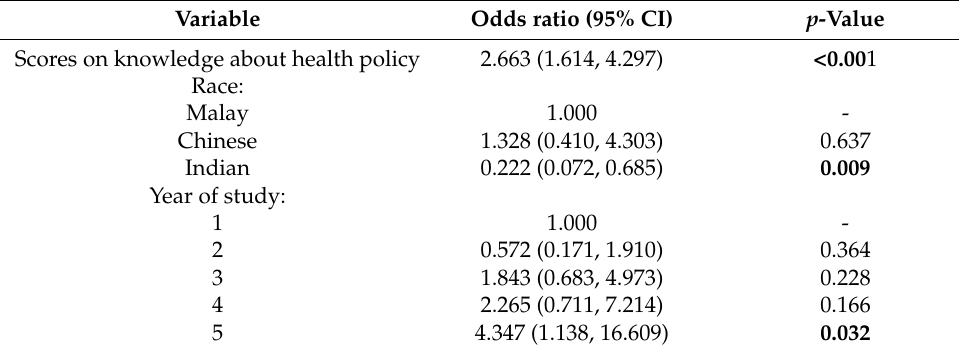
Table 5. Multiple logistic regression of factors associated with the student’s involvement in health policy roles ( n =